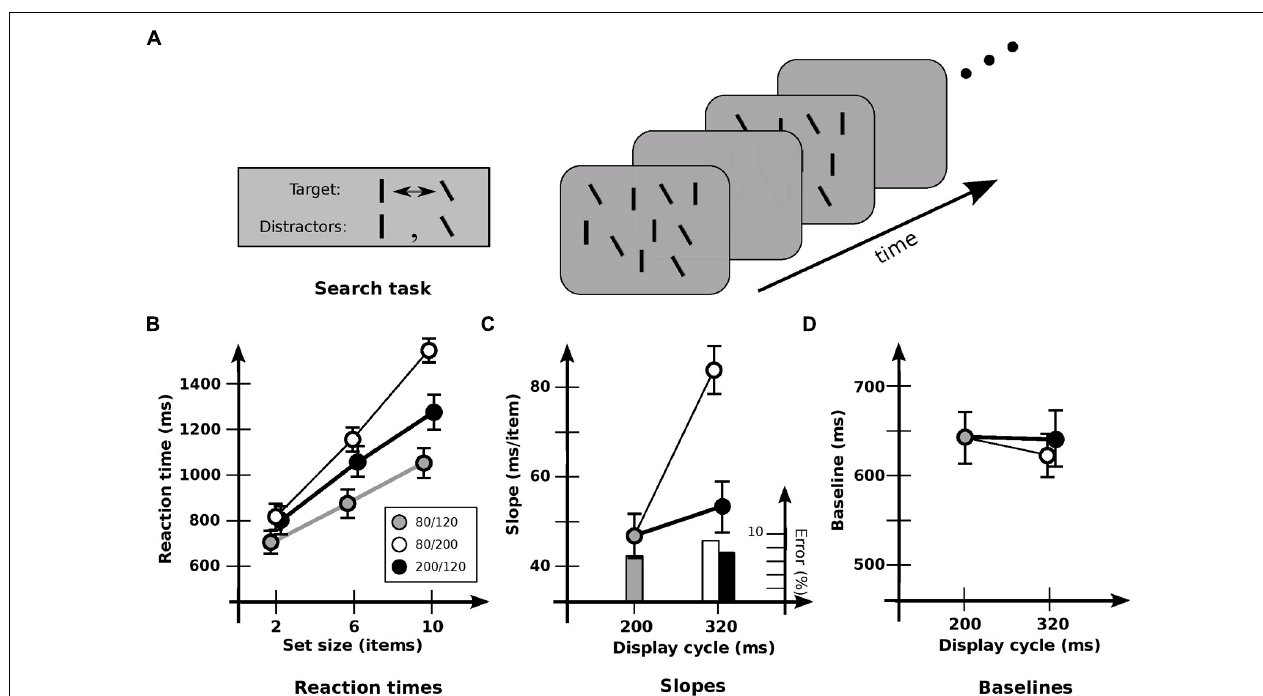
by an increase in off-time (83.0 ms/item) but not by an increase in on-time (53.7 ms/item). (D) Data recast as baselines.Values for the 80/240 and 200/120 cadences have been subtracted by 120 ms to equate the time of first appearance of the changed item. Baseline for base cadence (645 ms) is not significantly affected by an increase in off-time (615 ms) or on-time (641 ms). Error bars indicate standard error of the